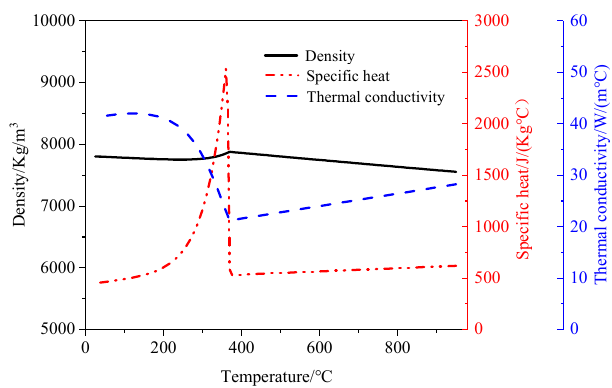
Figure 1. Physical properties of the steel.